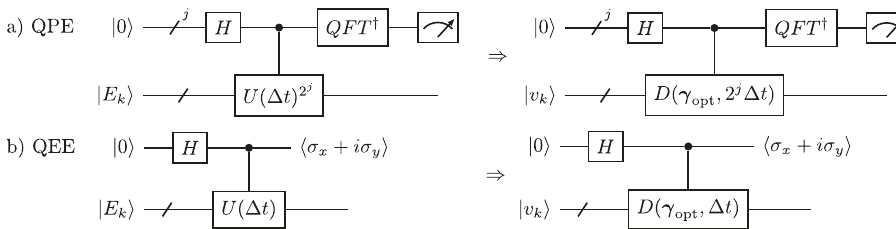
Fig. 8 Energy estimation circuits. a and b show circuit diagrams depicting the enhancement of QPE/QEE using fsVFF. A circuit depth reduction is achieved through replacing U ( Δ t ) with D ( γ opt , Δ t ), and removing the need to prepare an eigenstate in favor of a computational basis state, v k j i ¼ W y E k j i . QPE relies on implementing controlled unitaries of the form U ð Δ t Þ 2 j and therefore replacing these with D ( γ opt , 2 j Δ t ) results in an exponential reduction in circuit